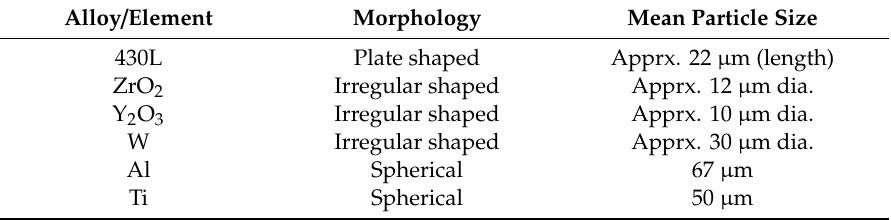
Table 2. The morphology and mean particle size of the starting materials (powders). Alloy / Element Morphology Mean Particle Size 430L Plate shaped Apprx. 22 µ m (length) ZrO 2 Irregular shaped Apprx. 12 µ m dia. Y 2 O 3 Irregular shaped Apprx. 10 µ m dia. W Irregular shaped Apprx. 30 µ m dia. Al Spherical 67 µ m Ti Spherical 50 µ